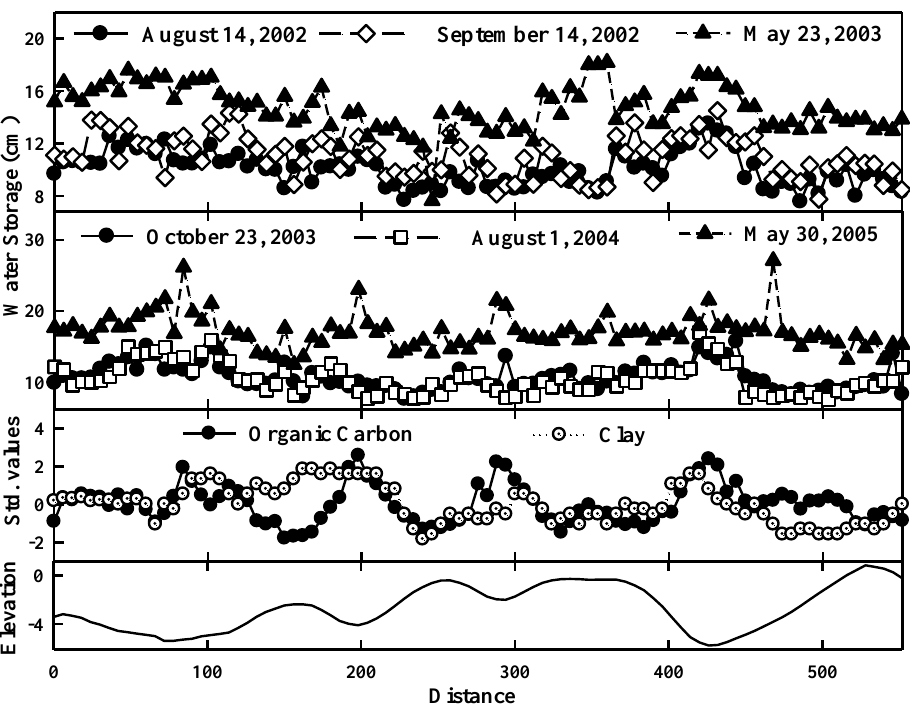
Fig. 1. Spatial distributions of ( A and B ) soil water storage (volumetric) at six occasions, (C) organic carbon and clay content, and (D) relative elevation along the sampling transect at the study site . A standardized value of organic carbon and clay content is calculated (for presentation simplicity) by subtracting the average value from a particular value and dividing by the standard deviation of the whole spatial series.